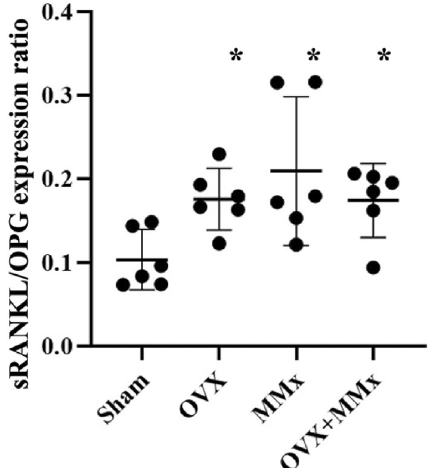
Figure 3. sRANKL/OPG expression ratio in subchondral bone. Lines represent the means and 95% CIs. *: p < 0.05 compared with the Sham group.